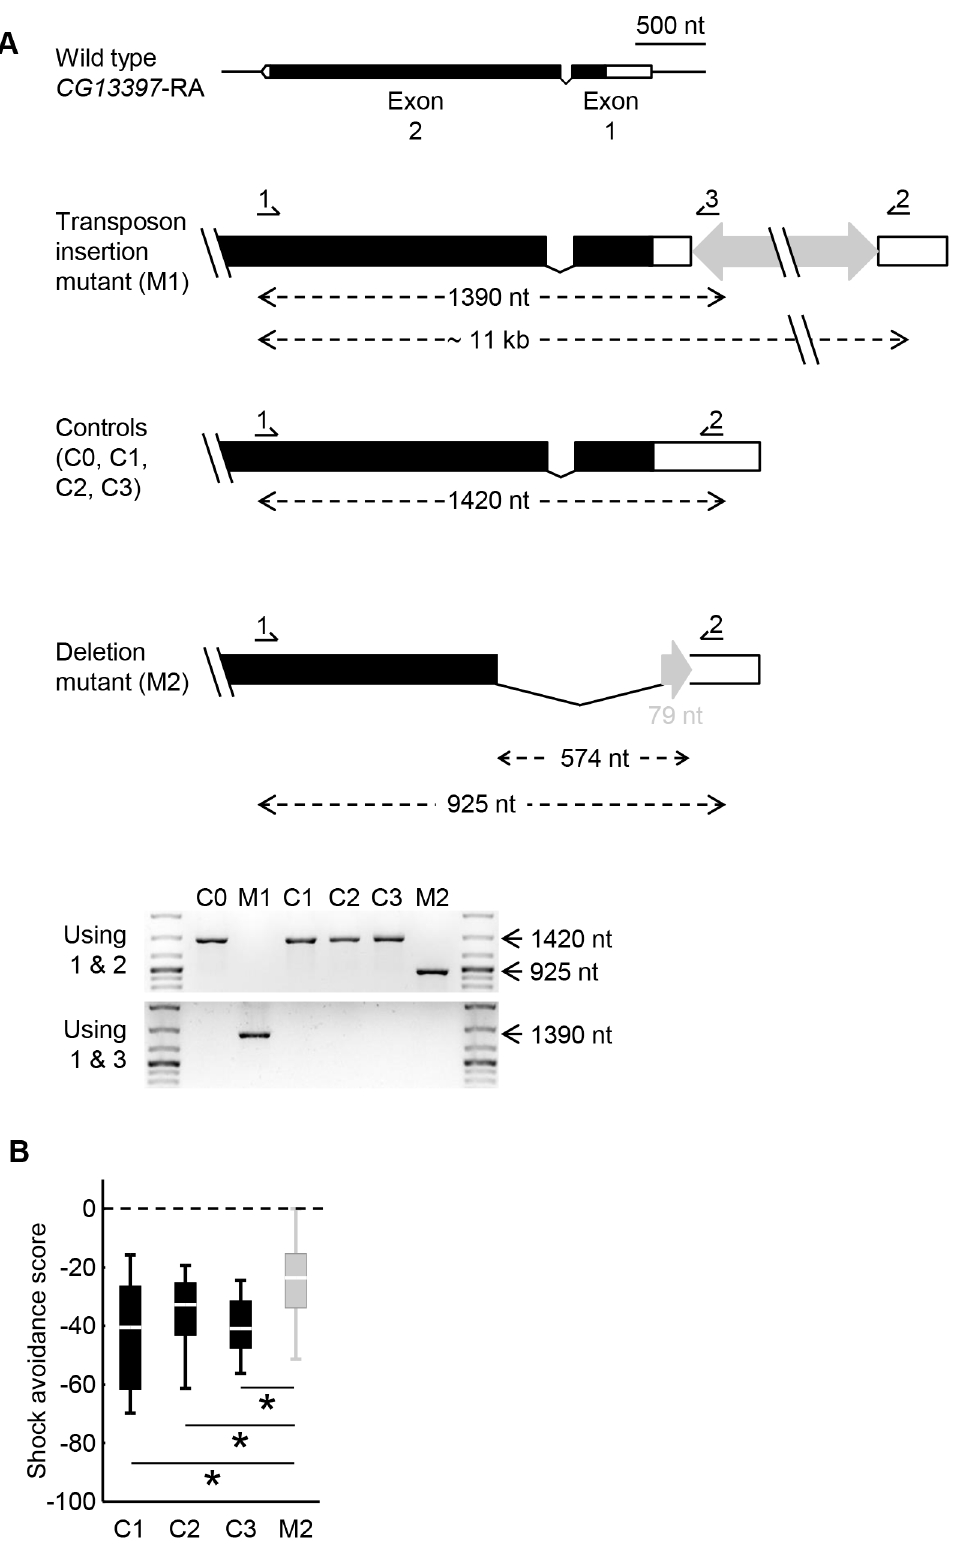
Fig 5. Validation of candidate shock avoidance gene CG13397 using a deletion mutant. A. We sketch the organization of the splice variant RA of the CG13397 in: a transposon insertion mutant (M1) and corresponding control strain (C0) as well as three independent control genotypes obtained by